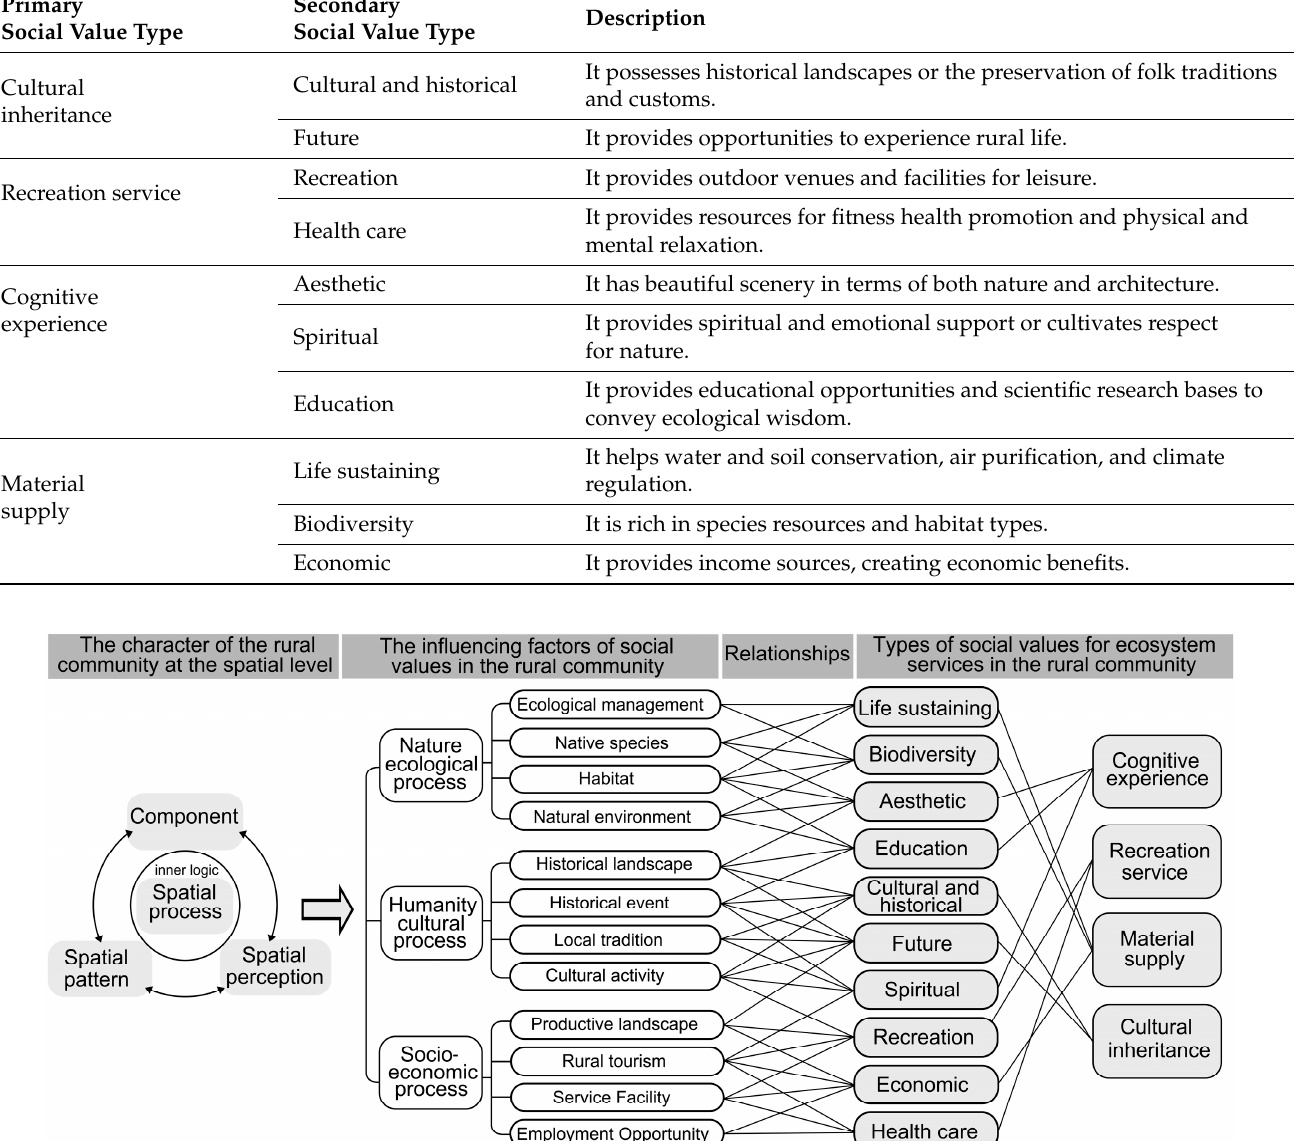
Table 1. Types and descriptions of social values for rural ecosystem services.